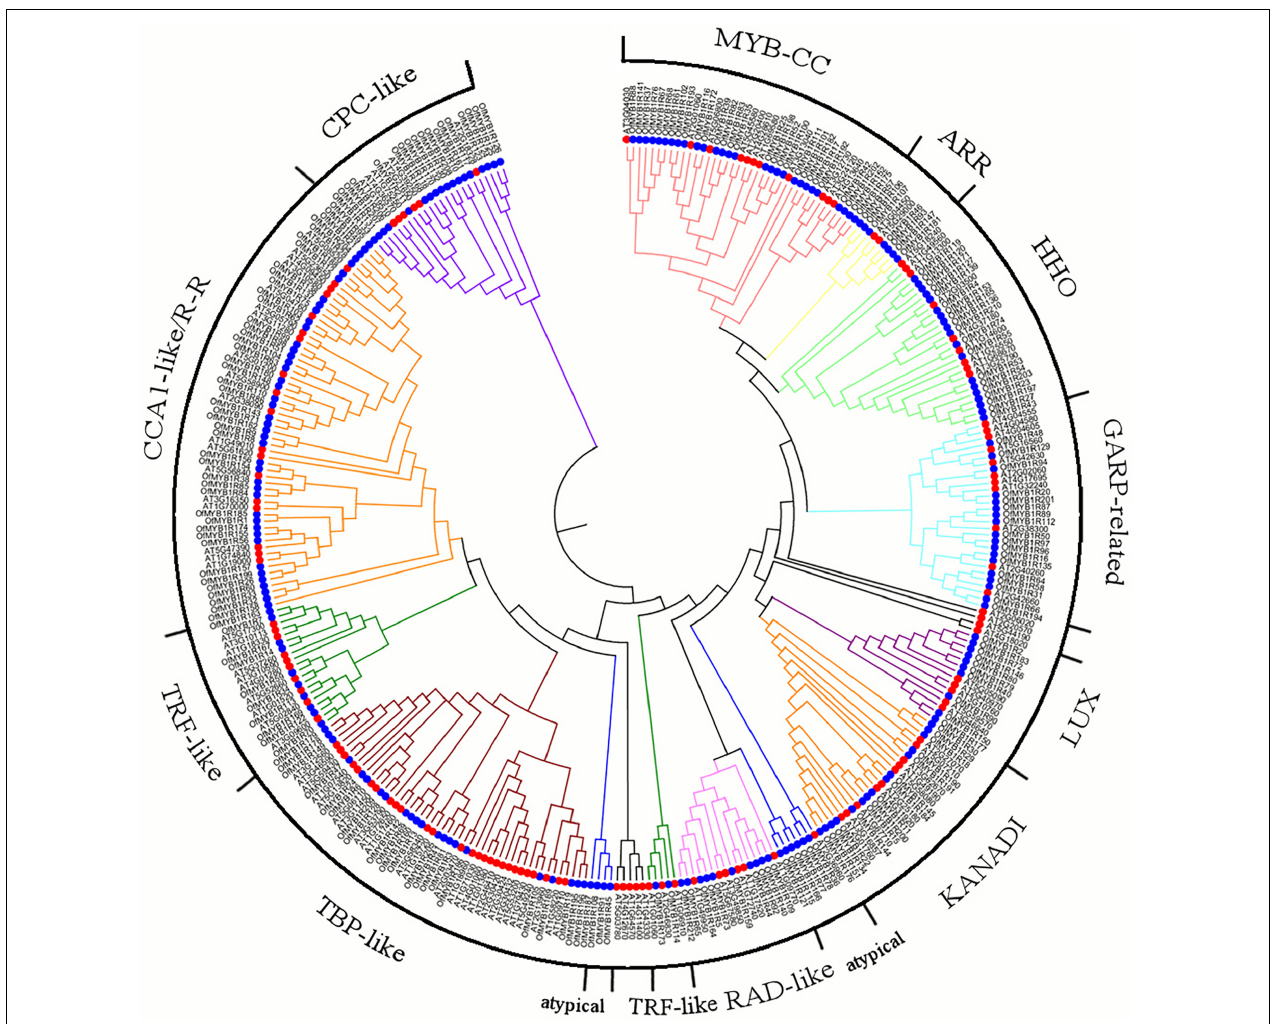
FIGURE 1 | Phylogenetic relationship between the 212 O. fragrans (blue circles) and 132 Arabidopsis (red circles) MYB-related proteins, illustrated by a maximum likelihood (ML) tree. Alignment was performed with the ClustalW program, and these proteins were imported to MEGA 7.0 to construct the phylogenetic tree with 1,000 bootstrap iterations. MYB1Rs represents OfMYB-related